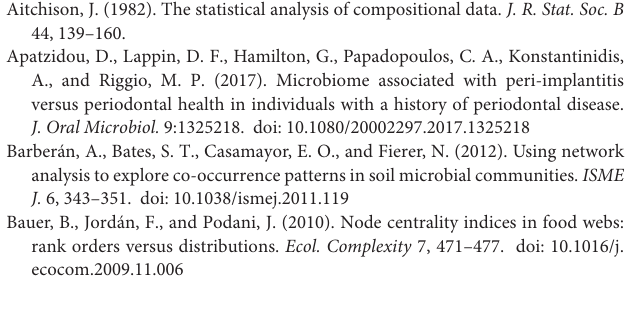
treatment for (D) 16S bacterial, (E) metabolite, and (F) metagenomic datasets. Larger distances indicate samples which are far from the group centroid, small distances indicate samples which are close to the group centroid. For the SHT study, distance from the centroid is shown for samples by disease class for (G) 16S bacterial, (H) metabolite, and (I) metagenomic datasets. Supplementary Figure 4 | Bacterial-cytokine correlation matrix for post-treatment, worsened samples. All spaces with color are p-adj < 0.05. Blue indicates a positive correlation; Dark orange indicates a negative correlation. Supplementary Figure 5 | Correlation matrices between comparisons of different SHT datasets (bacterial 16S-metabolite and bacterial 16S-metagenomic). (A) Bacterial-metabolite correlations on a combined dataset from all disease classes; (B) Bacterial-metabolite correlations on disease class “A.” All spaces with color are p-adj < 0.05. Blue indicates a positive correlation, Dark orange indicates a negative correlation. Supplementary Figure 6 | Microbial and cytokine balances for PT dataset at different conditions computed with selbal, where numerator genera are more relatively abundant than denominator genera for higher balance values. Balances are shown for samples before and after periodontal treatment for (A) bacterial 16S data, (B) cytokine, and (C) metagenomic data. Balances are shown for improved and worsened samples of (D) bacteria 16S data, (E) cytokine, and (F) metagenomic data. Supplementary Figure 7 | Microbial and cytokine balances for PT dataset for improved (A–C) and worsened (D–F) samples computed with selbal. Balances before and after treatment are shown for samples that improved for (A) bacterial 16S data (B) cytokine, and (C) metagenomic data. Balances before and after treatment are shown for samples that worsened for (D) bacterial 16S data, (E) cytokine, and (F) metagenomic data. Supplementary Figure 8 | Selbal-computed microbial and cytokine balances for PT dataset associated with the sum of all pocket depths. Balances for improved samples by pocket depth (response variable) are shown for (A) 16S bacterial, (B) cytokine, and (C) metagenomic datasets. Balances for worsened samples by pocket depth are shown for (D) 16S bacterial, (E) cytokine, and (F) metagenomic datasets. Supplementary Figure 9 | Selbal-computed balances for SHT dataset for microbial and metabolite balances by different characteristics. For samples with disease class either “A” or “C,” balances shown are for (A) 16S bacterial, (B) metabolite, and (C) metagenomic data. Balances for samples with disease class “A” associated with pocket depth sum are shown for (D) 16S bacterial, (E) metabolite, and (F) metagenomic datasets. Balances for disease class “C” samples associated with pocket depth sum are shown for (G) 16S bacterial, (H) metabolite, and (I) metagenomic datasets. Supplementary Figure 10 | Network degree distributions. For the PT study for networks with OTUs and cytokines, degree distribution of inferred network from patients who had (A) gingivitis or (B) moderate disease, (C) , shallow or (D) deep pockets. For the SHT study, degree distribution of inferred network from patients who had class (E) “A” or (F) “C”